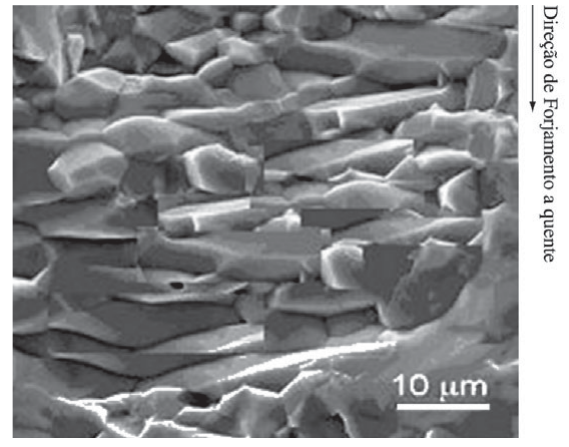
Figura 6. Superfície de fratura do plano paralelo ao eixo de forjamento em cerâmicas ferroelétricas de SBN63/37.